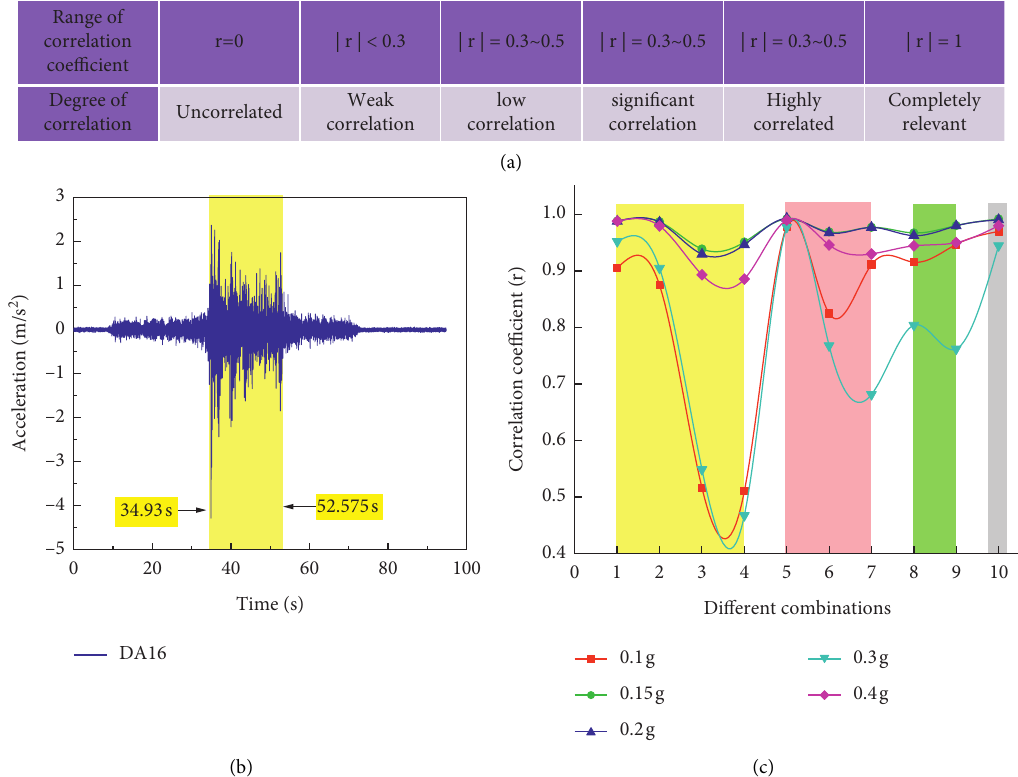
Figure 9: Correlation analysis. (a) Correlation coefficient. (b) Schematic diagram of data sampling space. (c) Correlation coefficient diagram of bridge pile measuring points under different working conditions (Note: 1–10, respectively, indicate different correlation analysis combinations, namely, DA18-DA12, DA18-DA23, DA18-DA14, DA18-DA17, DA12-DA23, DA12-DA14, DA12-DA17, DA23-DA14, DA23-DA17, and